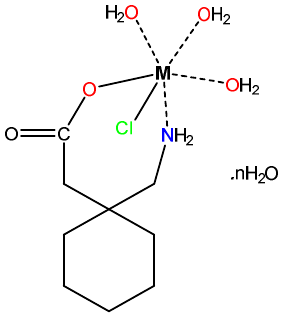
Figure 2. The structures of the synthesized Mn(II), Co(II), Ni(II), and Cu(II)–Gpn complexes, where = 2 for Cu(II), 3 for Ni(II), 4 for Mn(II), and 6 for Co(II). The FTIR spectra of the pure gabapentin and each of the Cu(II), Ni(II), Co(II), and Mn(II)–Gpn complexes were also obtained (Figure 3 and Table 1).